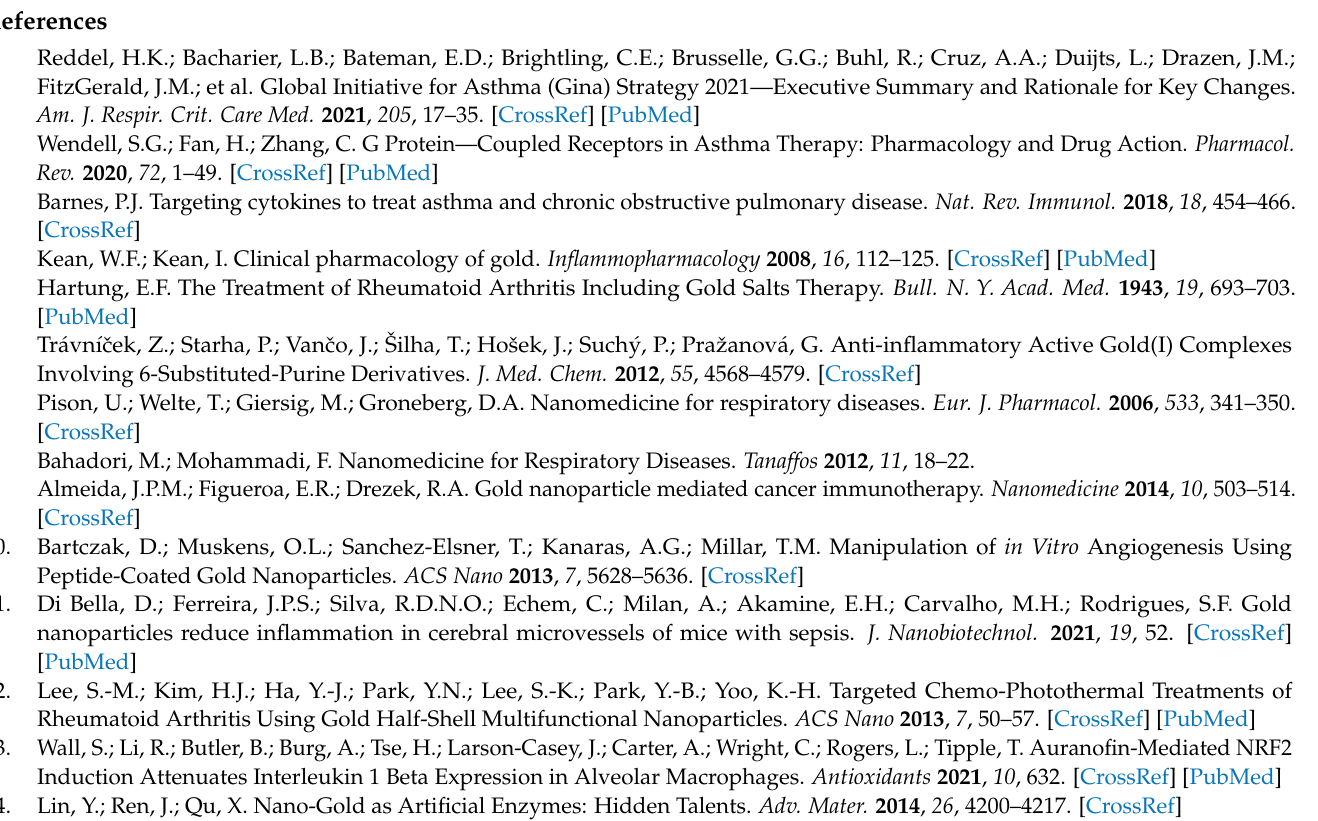
Figure A6. Upload of full gels for all Western blot images used to quantify HDAC2 as shown in Figure 6B. Red rectangles indicate lanes presented as representative blots in Figure